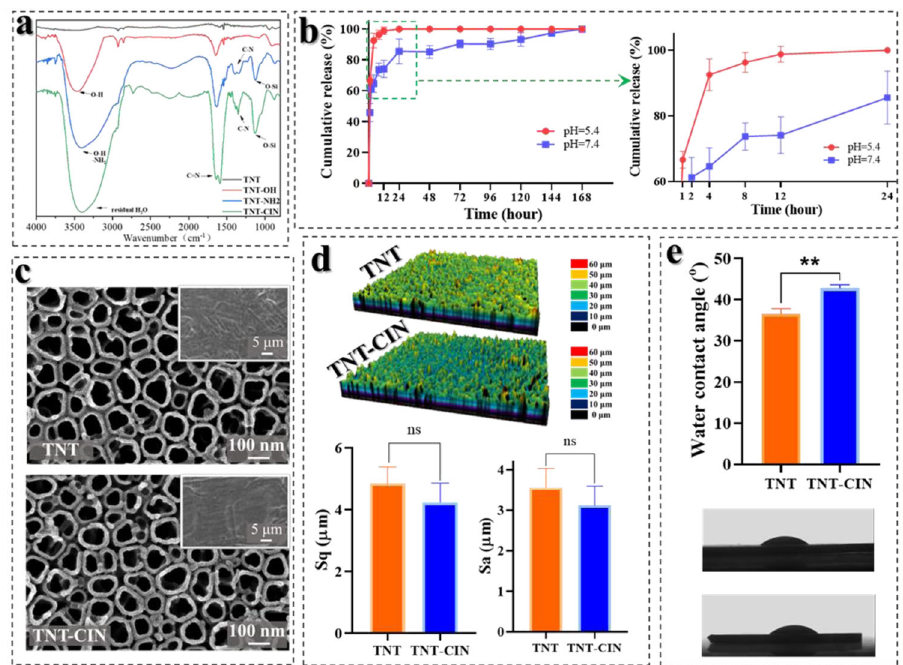
Fig. 1 The characterization of TNT and TNT-CIN. a The FTIR result showed characteristic groups after each reaction step, indicating the successful synthesis of TNT-CIN. b Cumulative release curve of CIN showed that the acidic microenvironment enhanced the release rate of TNT-CIN in the fi rst few hours. c The surface topography observed by SEM demonstrated that TNT-CIN retained the nanotube structure. d The roughness (Sa and Sq) did not signi fi cantly differ between TNT and TNT-CIN either. e The hydrophilicity of TNT-CIN was higher than that of